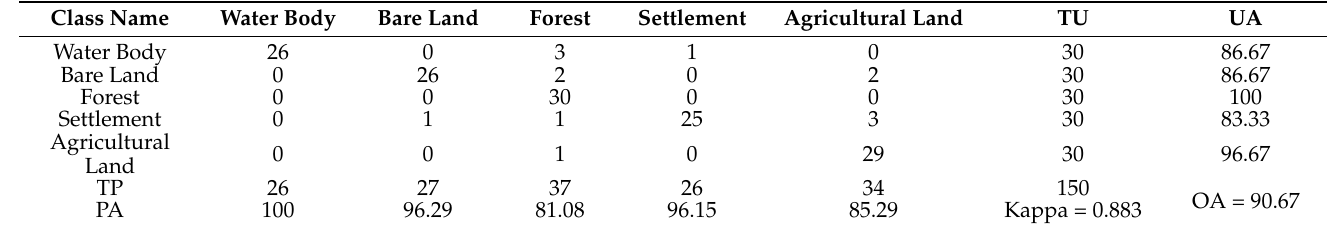
Table 5. Accuracy Assessment of Classified Map of December 2000.